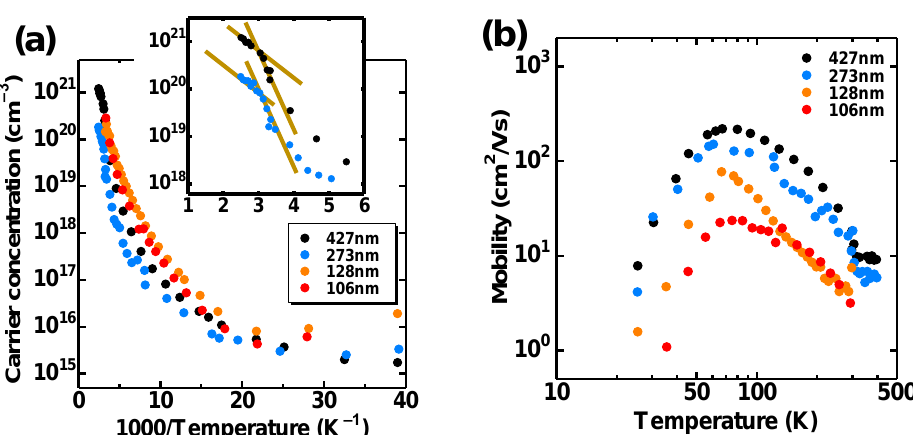
Figure 3. Temperature dependence of ( a ) carrier concentration and ( b ) Hall mobility for different thicknesses of Ta 2 NiSe 5 films. The inset of ( a ) presents an enlarged view of the data near the T c (328 K, 3.05 K −1 ) of the excitonic insulator transition.